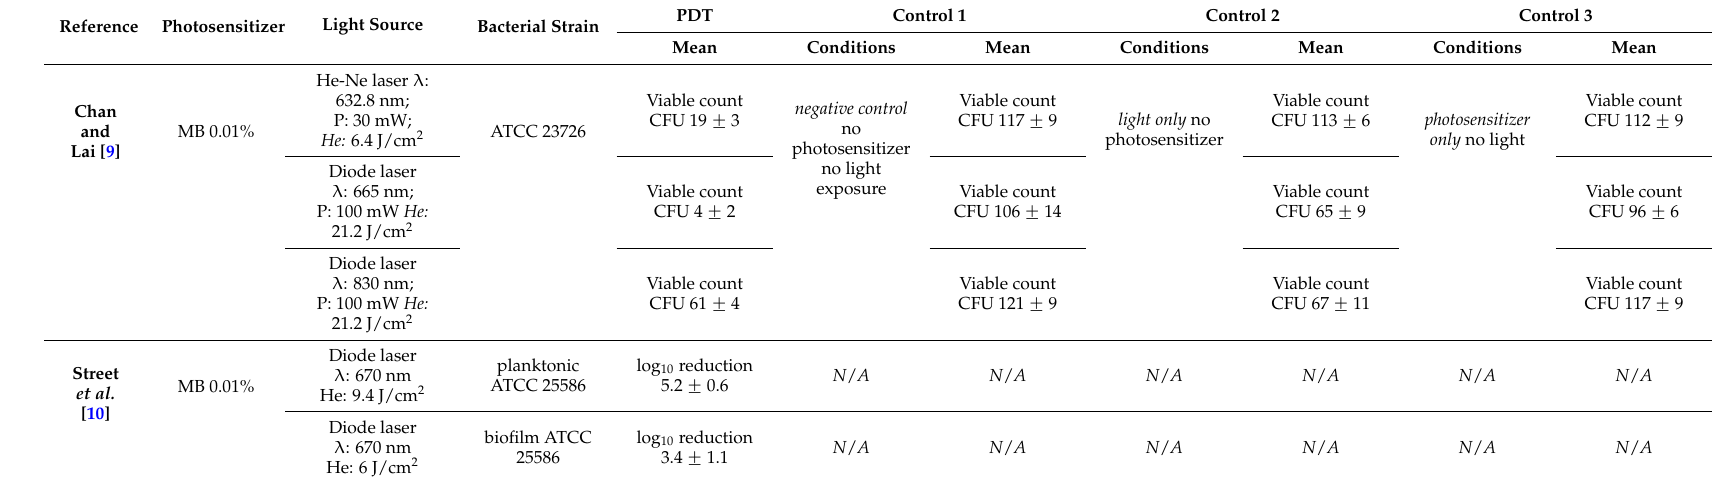
Table 3. Antimicrobial effects of photodynamic therapy (PDT) on